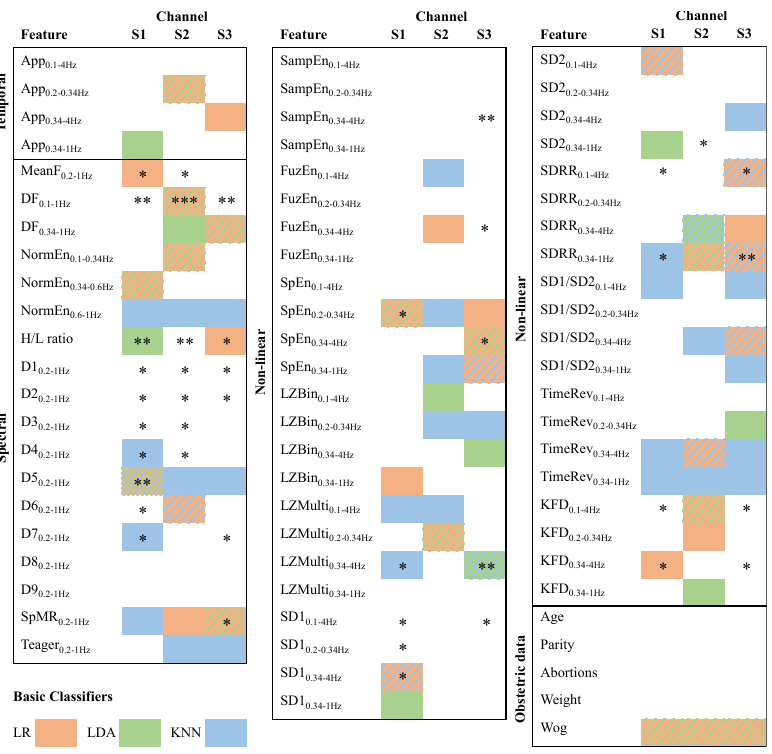
Figure 3. Optimized feature subset (best chromosomes) achieved using genetic algorithm for each base classifiers implemented with LR (orange), LDA (green), and KNN (blue). A single frame color indicates that a feature is part of the classifier’s best chromosome identified with that color; two and three frame colors indicate that the feature belongs to two and three classifiers’ best chromosome, identified with the corresponding colours. *, ** and *** mean a p -value of the Wilcoxon Rank-Sum test lower than 0.05, 0.005 and 0.0005, respectively, computed by each feature between preterm and term labor